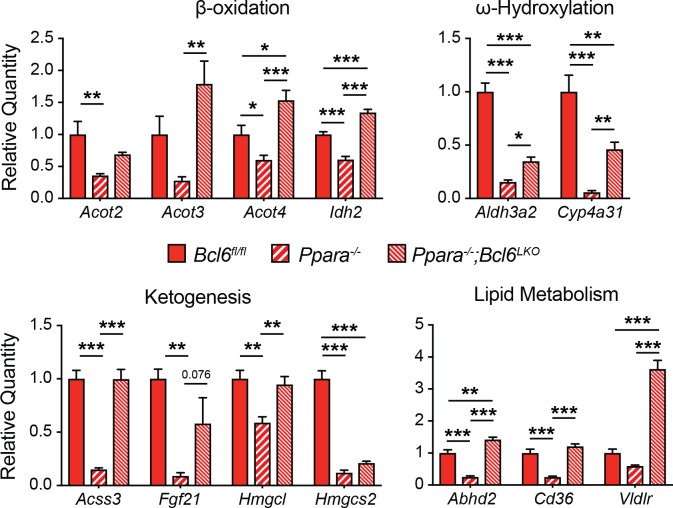
BCL6 deletion in Ppara-/- mice restores fasting gene expression.qPCR analysis of PPARα- and fasting-regulated transcripts in overnight fasted Bcl6fl/fl, Ppara-/-, and Ppara-/-;Bcl6LKO mouse livers, N = 5–6 per group. A one-way ANOVA and Holm-Sidak’s post-hoc testing was used to compare mean expression between groups. ∗p<0.05, ∗∗p<0.01, ∗∗∗p<0.001.